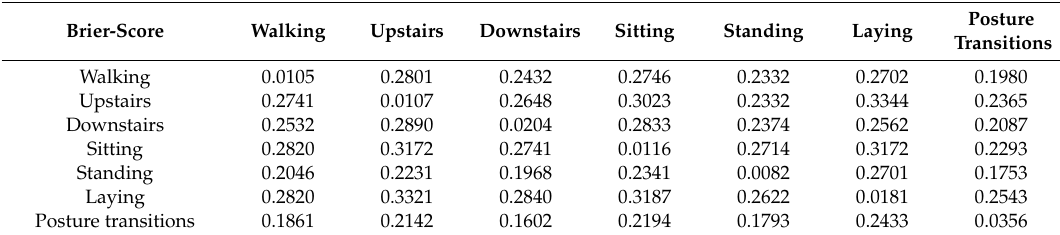
Table 9. Brier score evaluation result of probability